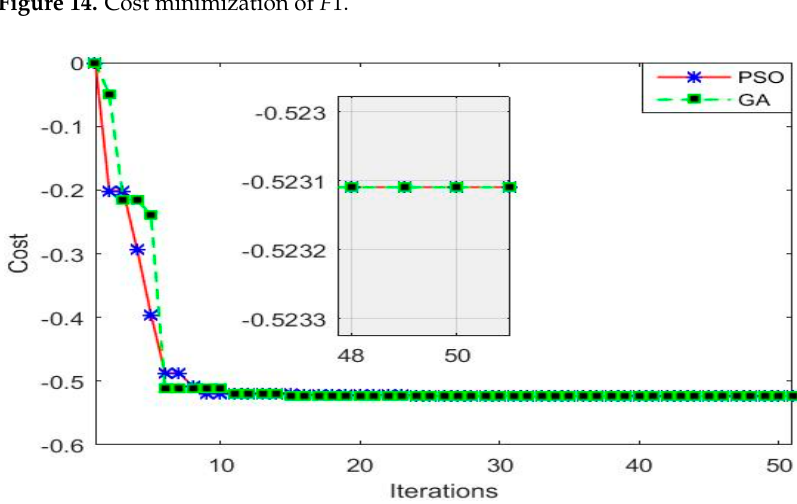
Figure 15. Cost minimization of F 3.